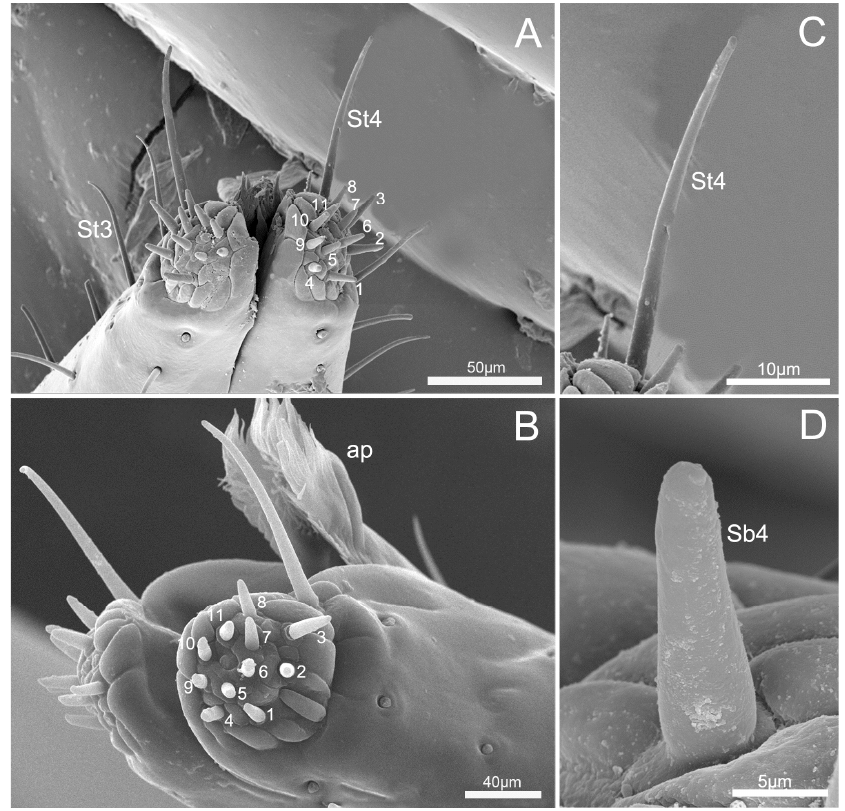
Figure 7. SEM images the tip of labium of C. nigrescens. ( A ) Vertical view of the tip of labium showing 11 sensilla basiconca IV (Sb 4), sensilla trichodea III (St 3), and sensilla trichodea IV (St 4); ( B ) half view of labial tip showing 11 sensilla basiconica IV (Sb 4) and apical plate (ap); ( C ) enlarged view of sensillum trichodeum IV (St 4); and ( D ) enlarged view of sensillum trichodeum IV (Sb 4).